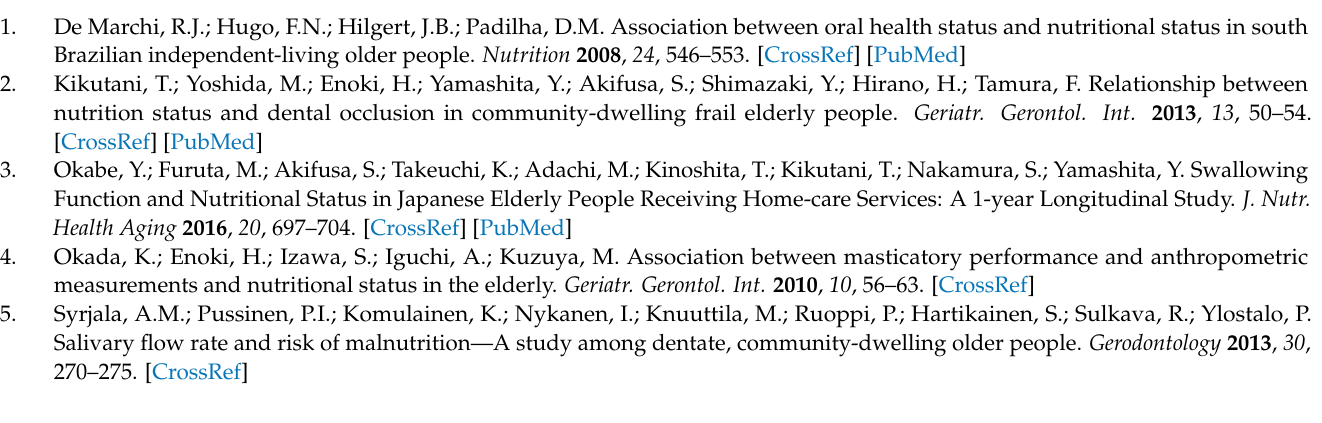
examinations, Table S2: Three logistic regression models for the association between the number of components of oral frailty and deteriorating nutritional status based on the MNA ® -SF